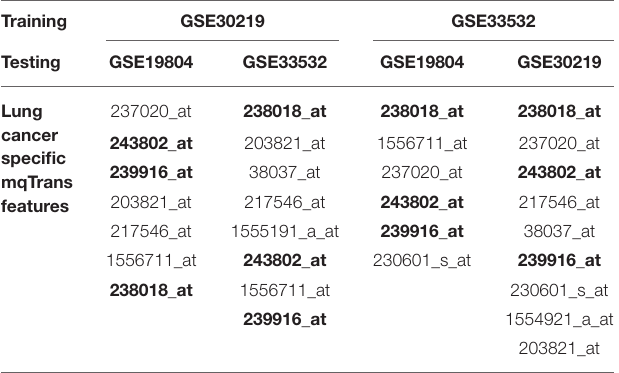
TABLE 3 | The 29 lung cancer mqTrans biomarkers confirmed by the cross-dataset validations.